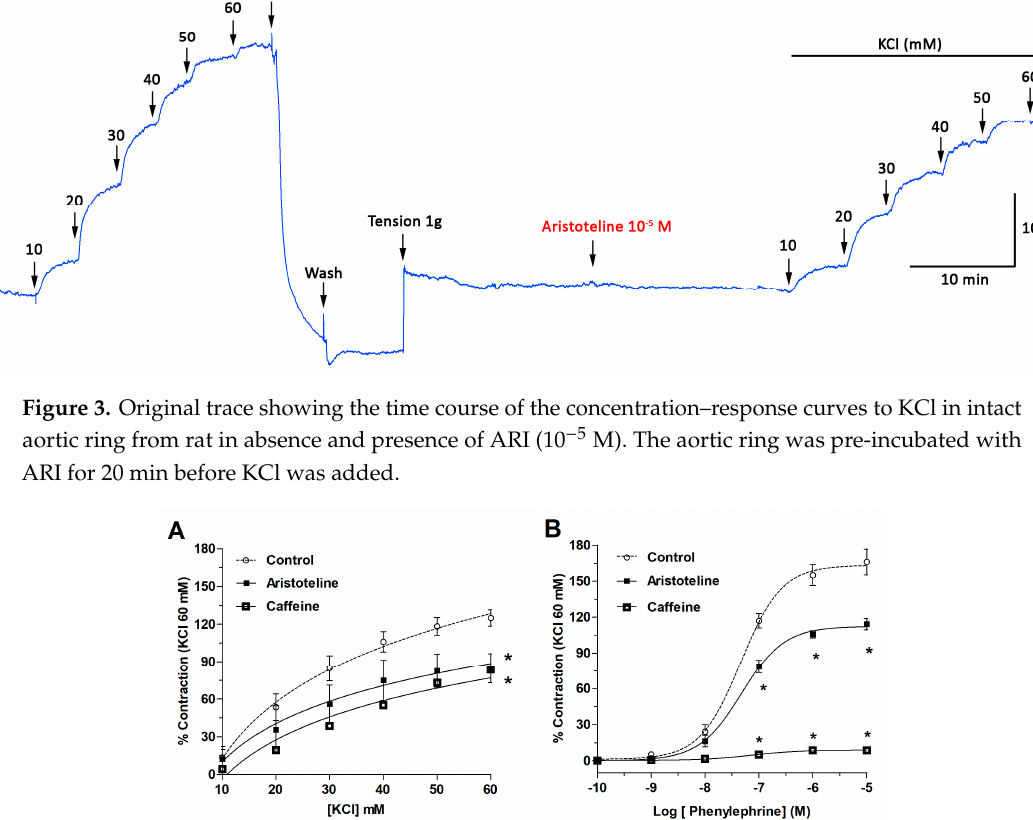
Figure 4. E ff ect of ARI on the contractile response to KCl ( A ) and PE ( B ) in rat aortic ring. The aorta was pre-incubated in absence (control) or presence of ARI (10 µ M) or ca ff eine (10 mM) for 20 min. Values are the mean ± standard error of the means of 6 experiments. The asterisks in ( A ) refer to both, ARI and ca ff eine. The determination of EC 50 were performed using nonlinear regression and a repeated-measures two-way ANOVA to compare curves. Statistically significant di ff erence * p < 0.05 vs. Control. Table 2. E ff ect of ARI on the vascular response to KCl, phenylephrine (PE) and calcium in rat aorta.